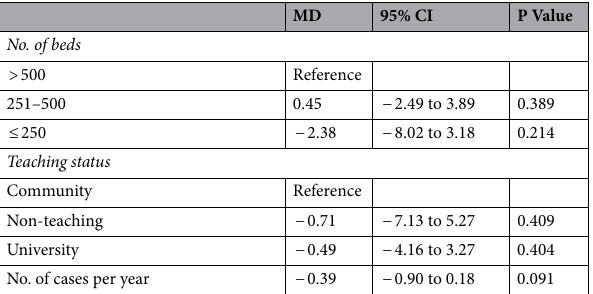
Table 2. Association of patient- and hospital-level characteristics with timing of surgical decompression for acute thoracolumbar SCI. MVC Motor Vehicle Collision; ISS Injury Severity Score; GCS Glasgow Coma Scale; ED Emergency Department; SBP Systolic Blood